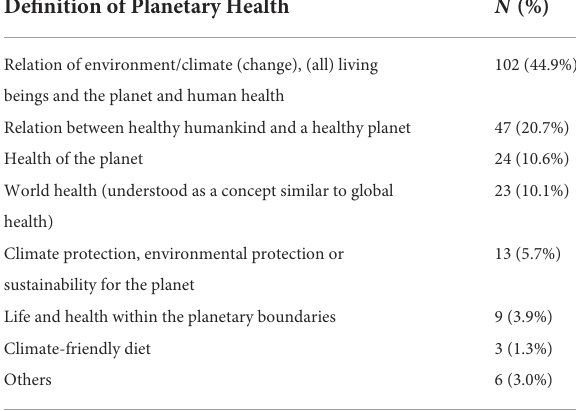
TABLE 3 Students’ definition of Planetary Health ( N =